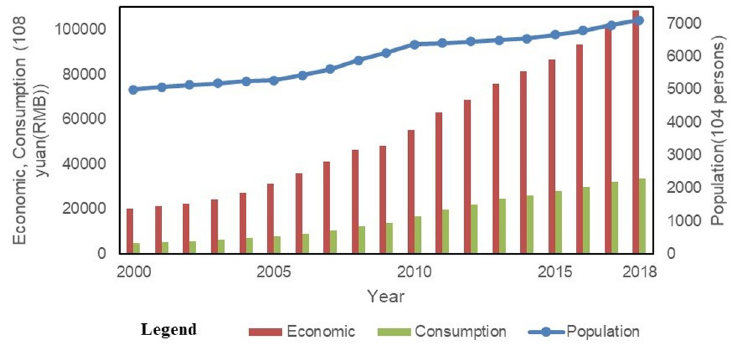
Fig 2. The development of the population, GDP and total retail sales of the GBA from 2000 to 2018.